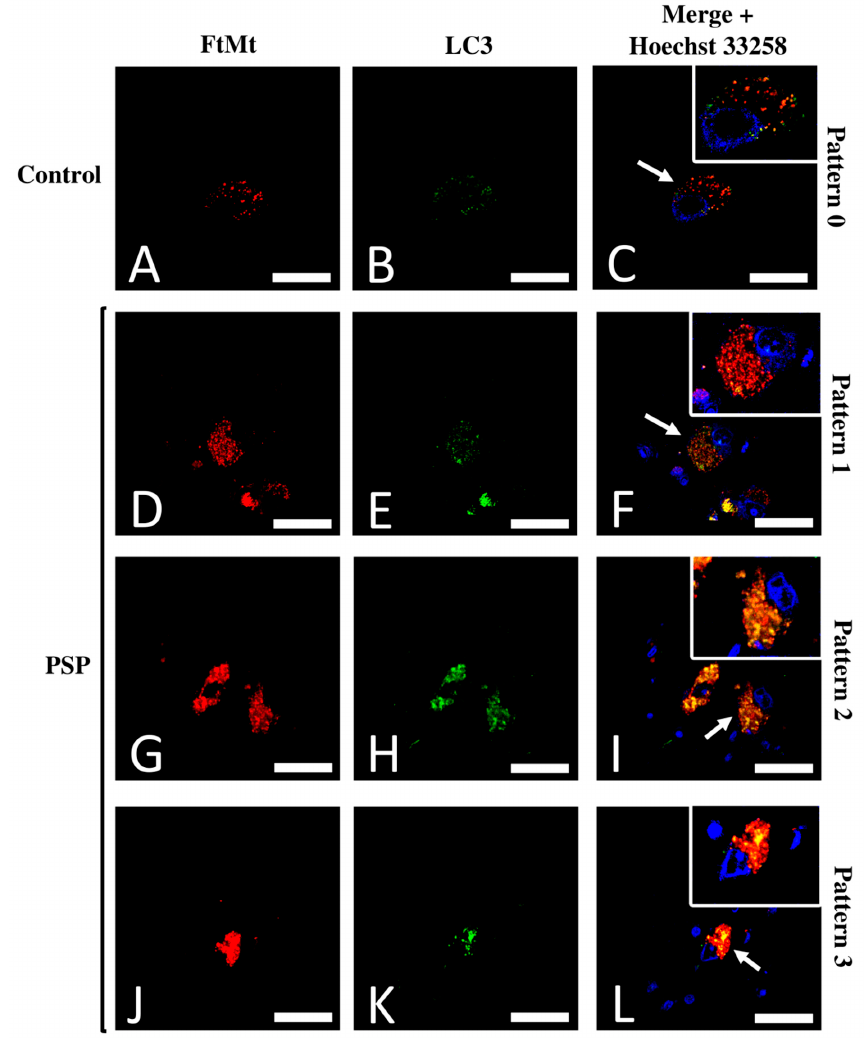
Figure 3. Typical patterns of the FtMt-IR and LC3-IR colocalization. ( A ) FtMt-IR in a control case’s SNc. ( B ) LC3-IR in a control case’s SNc. ( C ) Merged images ( A , B ); the arrow points to a neuron with a typical “pattern 0.” ( D ) FtMt-IR in a PSP case’s SNc. ( E ) The LC3-IR in a PSP case’s SNc. ( F ) Merged images ( D , E ); the arrow points to a neuron with a typical “pattern 1.” ( G ) FtMt-IR in a PSP case’s SNc. ( H ) LC3-IR in a PSP case’s SNc. ( I ) Merged images G and H ; the arrow points to a neuron with a typical “pattern 2.” ( J ) FtMt-IR in a PSP case’s SNc. ( K ) LC3-IR in a PSP case’s SNc. ( L ) Merged images ( J , K ); the arrow points to a neuron with a typical “pattern 3.” Panels ( C , F , I , L ) contain an additional inset with vivid nuclei staining to illustrate the boundaries of the cell nucleus (magnification is the same as the main panel). Pictures in ( A – C ) were from the control-1 case. Pictures in ( D – F ) were from the PSP-3 case. Pictures in ( G – I ) were from the PSP-4 case. Pictures in ( J – L ) were from the PSP-2 case. Nuclei stained with Hoechst 33258 are shown in the merged images. All scale bars: 20 µ